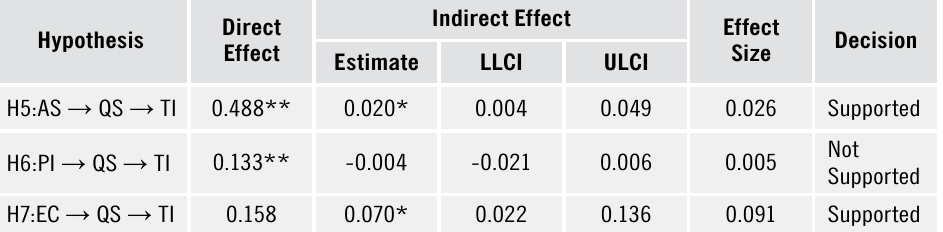
Table 5. Mediation effect of Quiescent